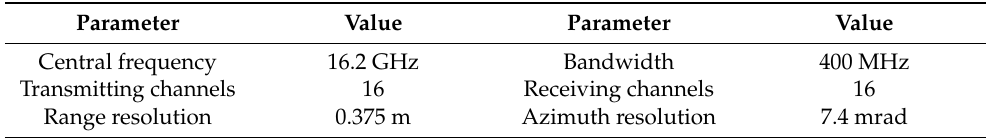
Table 2. Technical characteristics of GB-MIMO